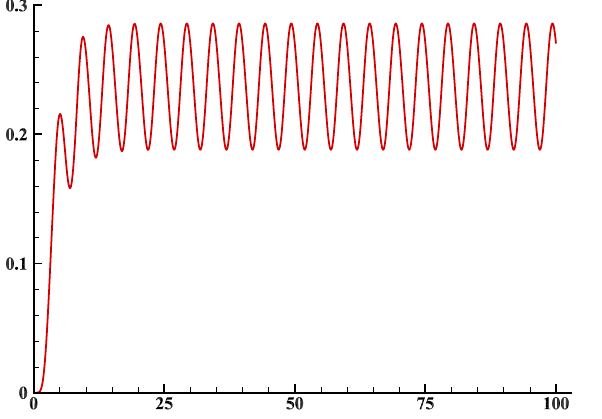
Figure 5. Lid-driven open cavity flow with flexible bottom wall. Evolution of maximum deviation of membrane y m over